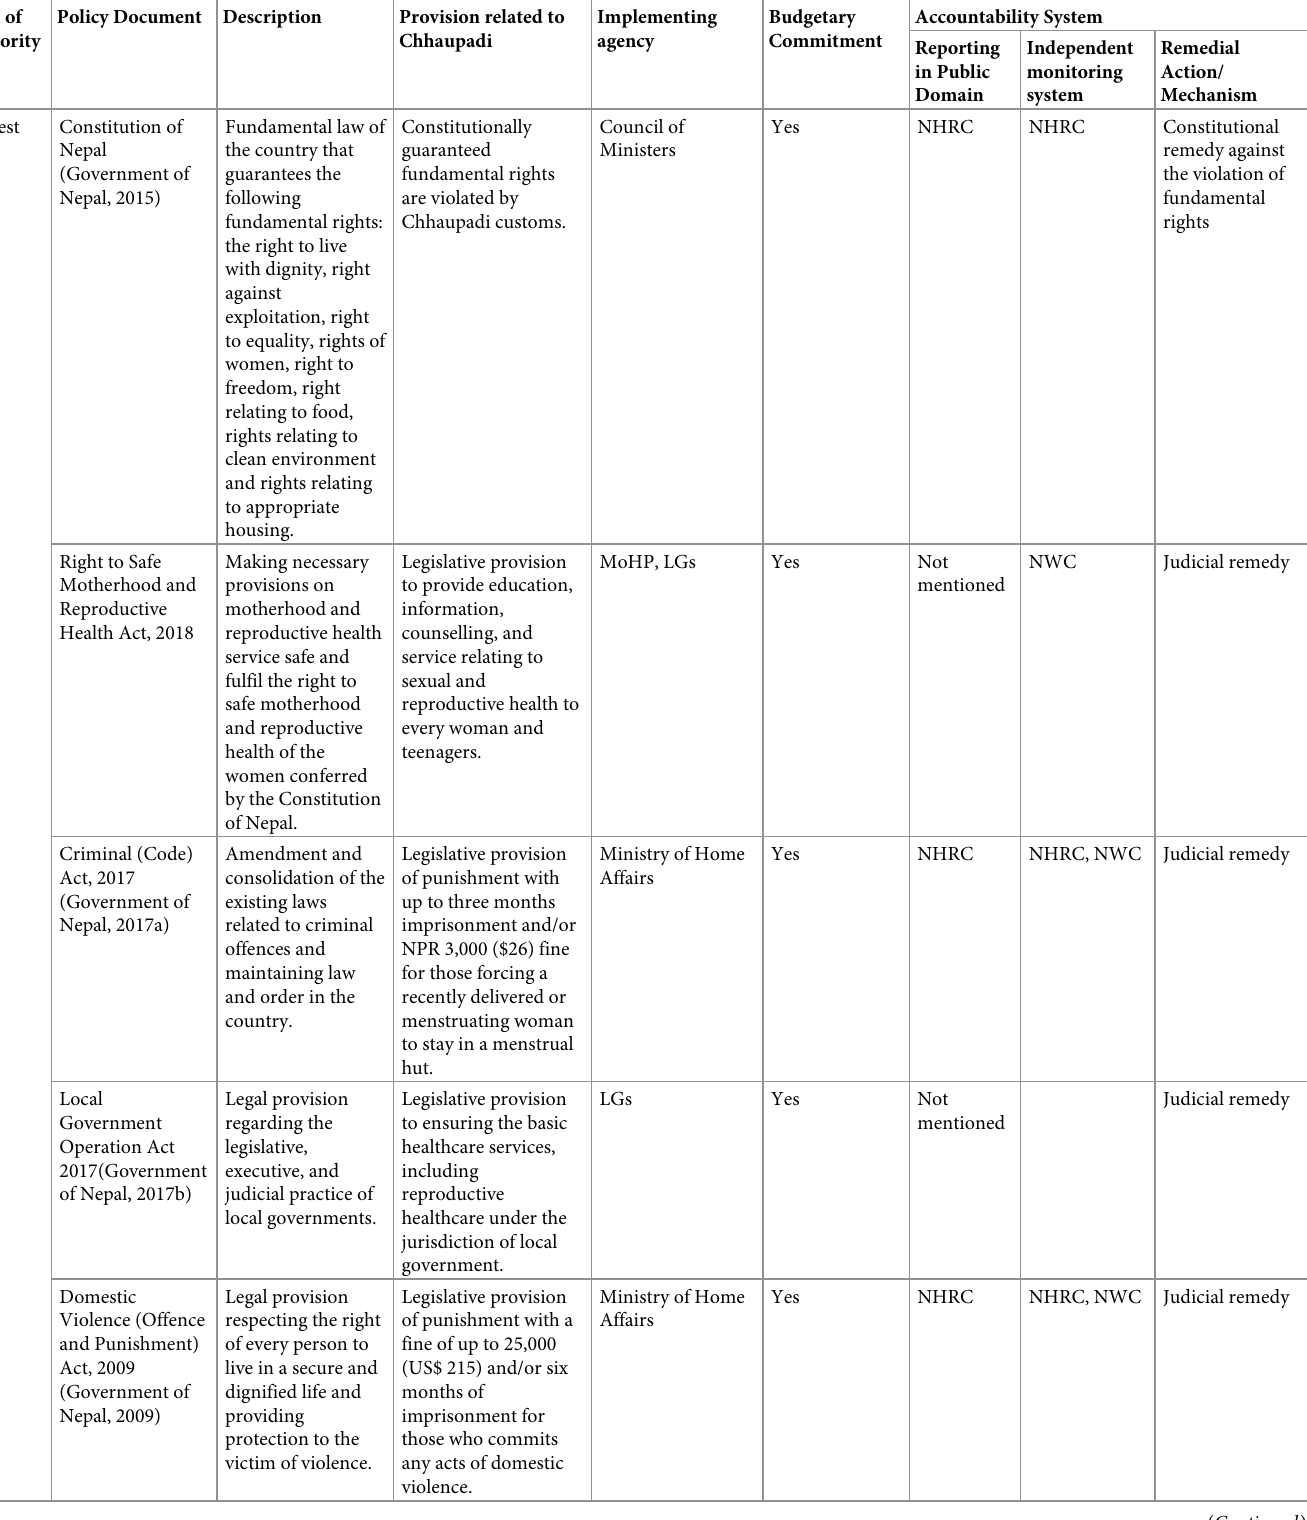
Table 3. Salience features and effectiveness of means of implementation of relevant policies on the eradication of Chhaupadi practice in Nepal, 2020. Level of Policy Document Authority